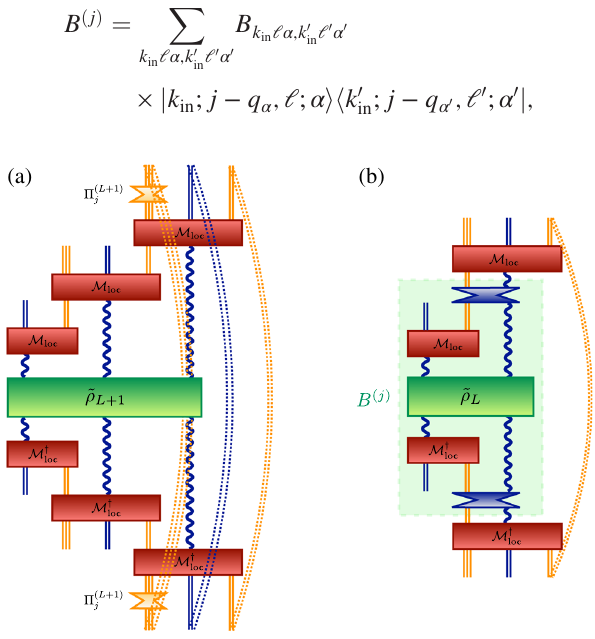
FIG. 16. RDM corresponding to a fixed flux sector j , computed in the full basis. (a) ρ j in the full basis. After pushing the L projectors through as explained in the text and using that M ð L þ is an isometry, one obtains the equivalent form depicted in panel